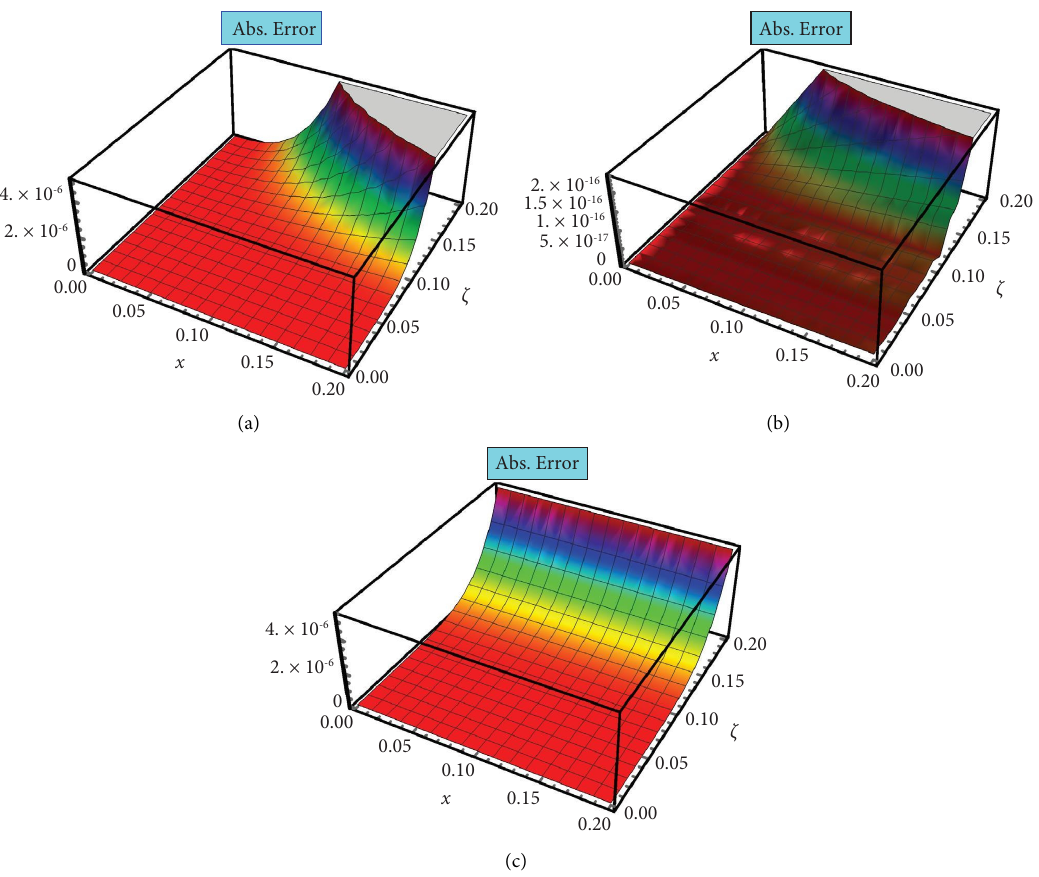
Figure 3: In Figure 3, the 3D curve of | w ( ϰ , ζ ) − w 5 ( ϰ , ζ )| in the ranges ζ ∈ [ 0 , 0 . 2 ] and ϖ ∈ [ 0 , 0 . 2 ] , when ϖ � 1 . 0 for (a) Problem 1, (b) Problem 2, and (c) Problem 3, when λ � 2 . 0. Table 1: | w 4 ( ϰ , ζ ) − w 3 ( ϰ , ζ )| of Problem 1 at diferent values of ϖ at ϰ � 0 . 002 determined by LRPSM at plausible locations in the range